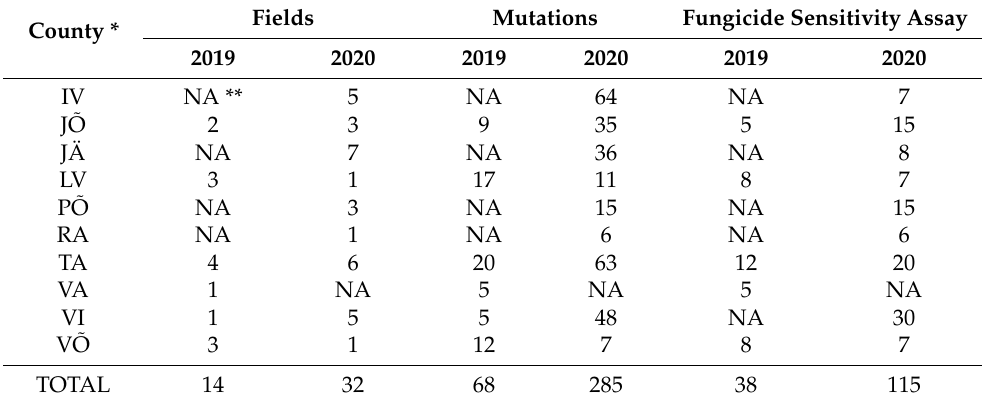
Table 1. The number of R. collo-cygni collection fields and isolates analysed for mutations in fungicide target genes and fungicide sensitivity in microtiter plate assays by counties and